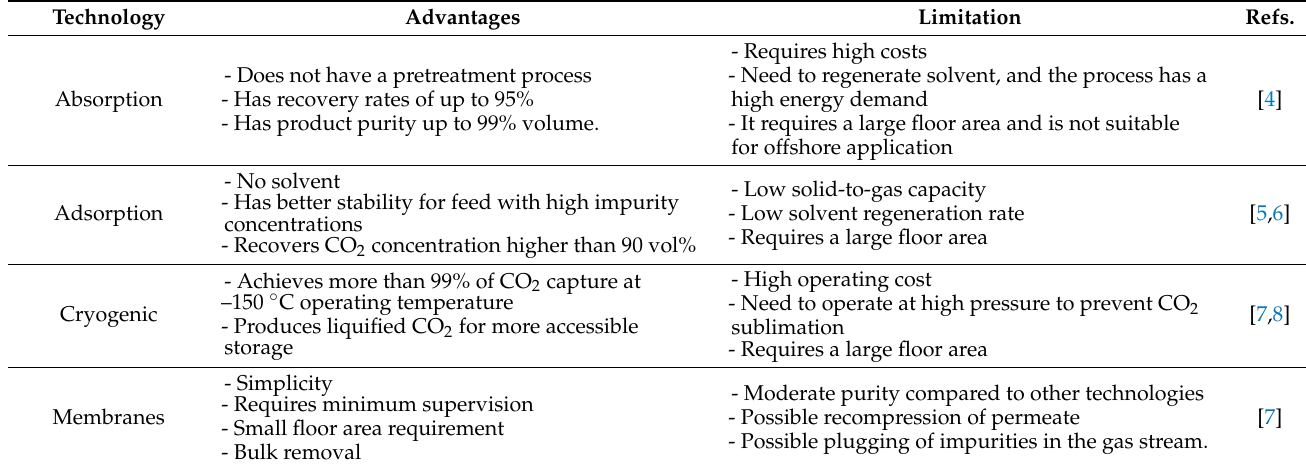
Table 1. Advantages and limitations of separation